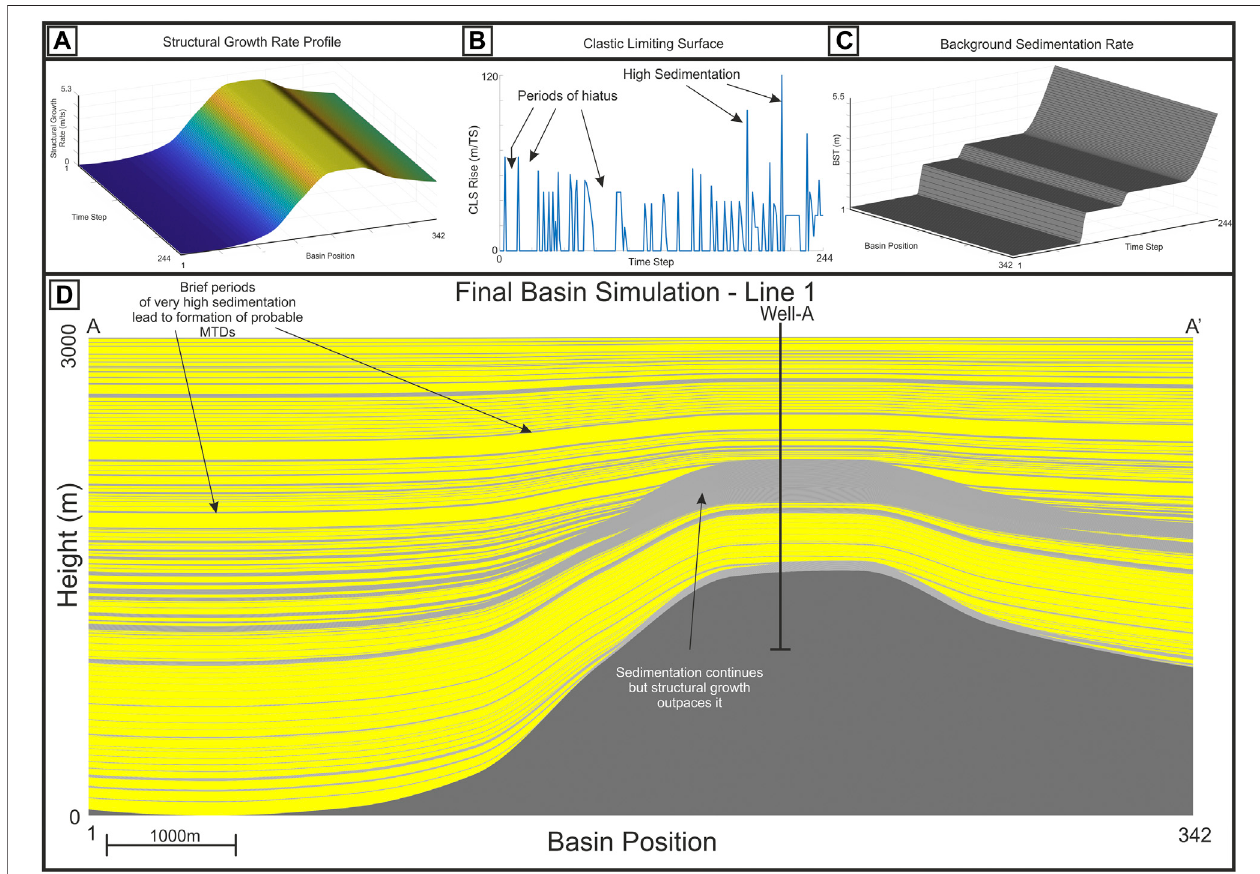
FIGURE 6 | Inputs used to model the evolution of Line 1. (A) 3D Representation of the Structural Growth Pro fi le, X axis represents position in space, Y Axis represents position in Time, Z axis represents the growth that the structure grows in meters per time step. (B) The rate of rise of the clastic limiting surface; showing the sporadic nature and short lived time in which sediment gravity fl ows occur in the cross-section. (C) Background Sedimentation Rate; derived from data from Well-A. X Axis represents position in space along the cross section, Y axis represents position in time, and Z axis represents amount of background sediment deposited in meters. (D) Final simulation for Line 1, highlighting periods of very high, but short lived, sedimentation (which probably correspond to MTDs) and periods of hiatus in sedimentation.